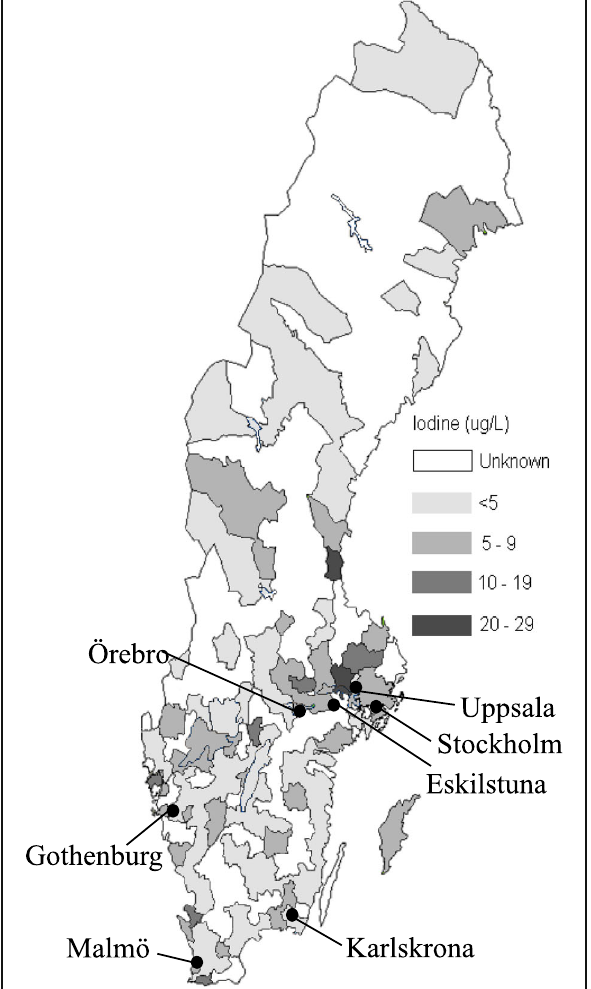
Fig. 1 Level of water iodine concentration (WIC) from water treatment plants in 166 Swedish